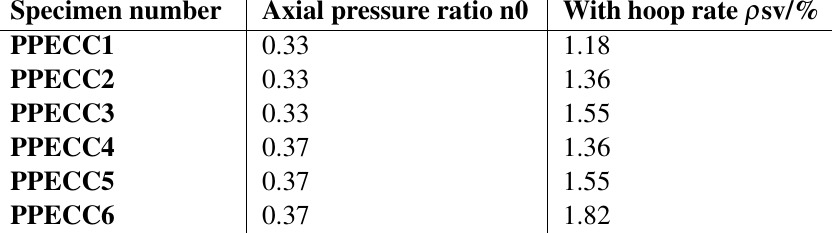
Table 1 The main parameters of the test